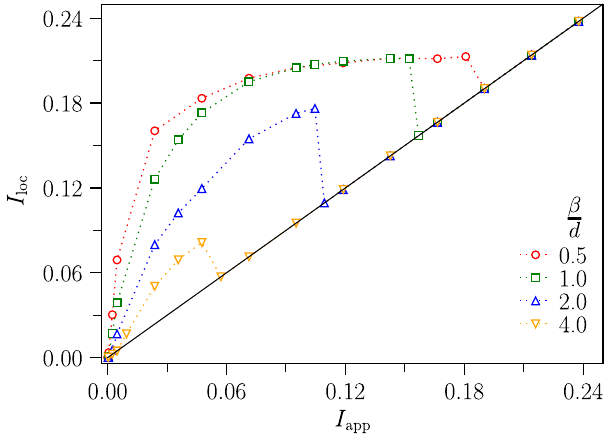
FIG. 8. The local inertial number I apparent inertial number I H=d ¼ 29 . Data are extracted from steady v following the steady shear rate up